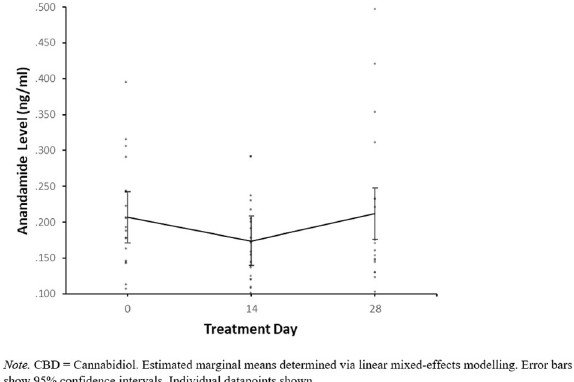
Fig. 3 Estimated marginal means of anandamide levels in the 800 mg CBD group by week.